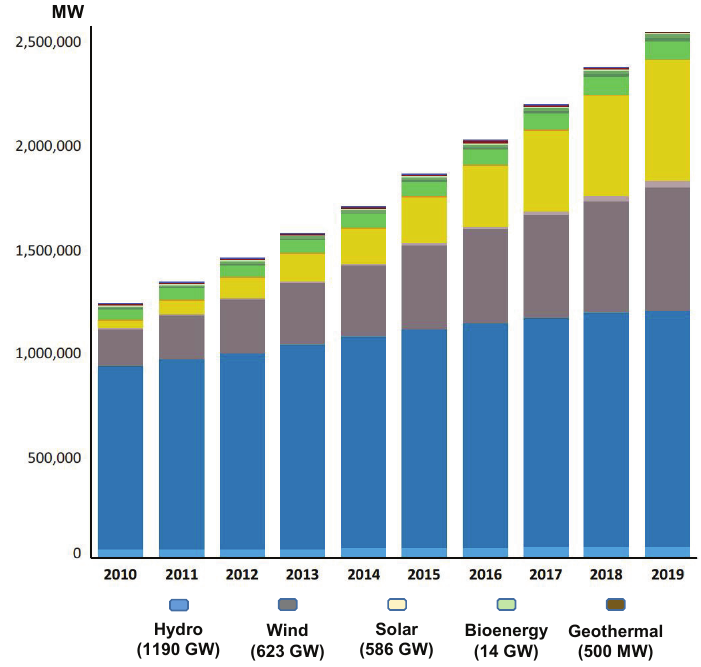
Figure 2. Energy generation capacity by RES